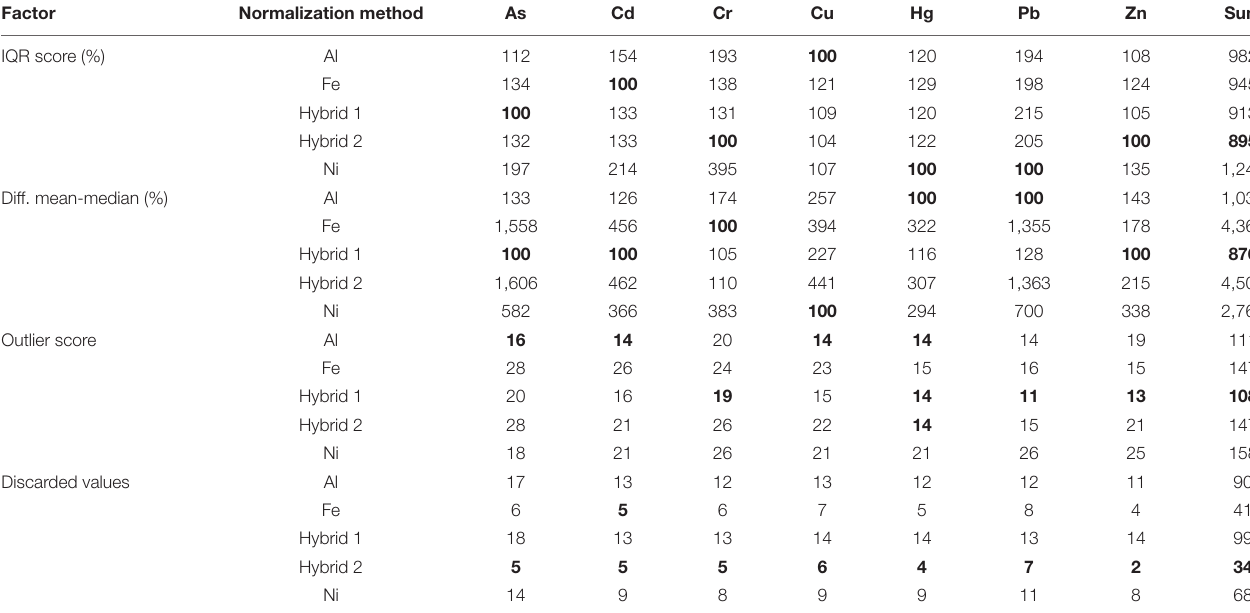
TABLE 4 | Variability performance of the five normalization